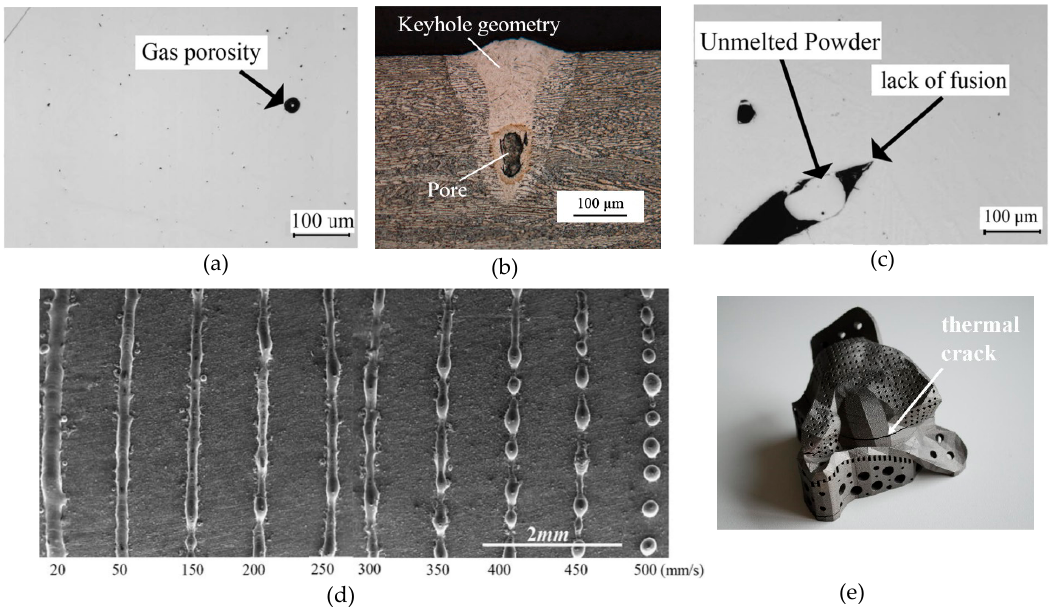
Figure 3. Micrographs of defects observed in L-PBF, such as ( a ) gas porosities [22], ( b ) key hole porosity [29], ( c ) lack of fusion defect [22], ( d ) balling [39], and ( e ) thermal crack [49]. Reused under Creative Commons Attribution License.